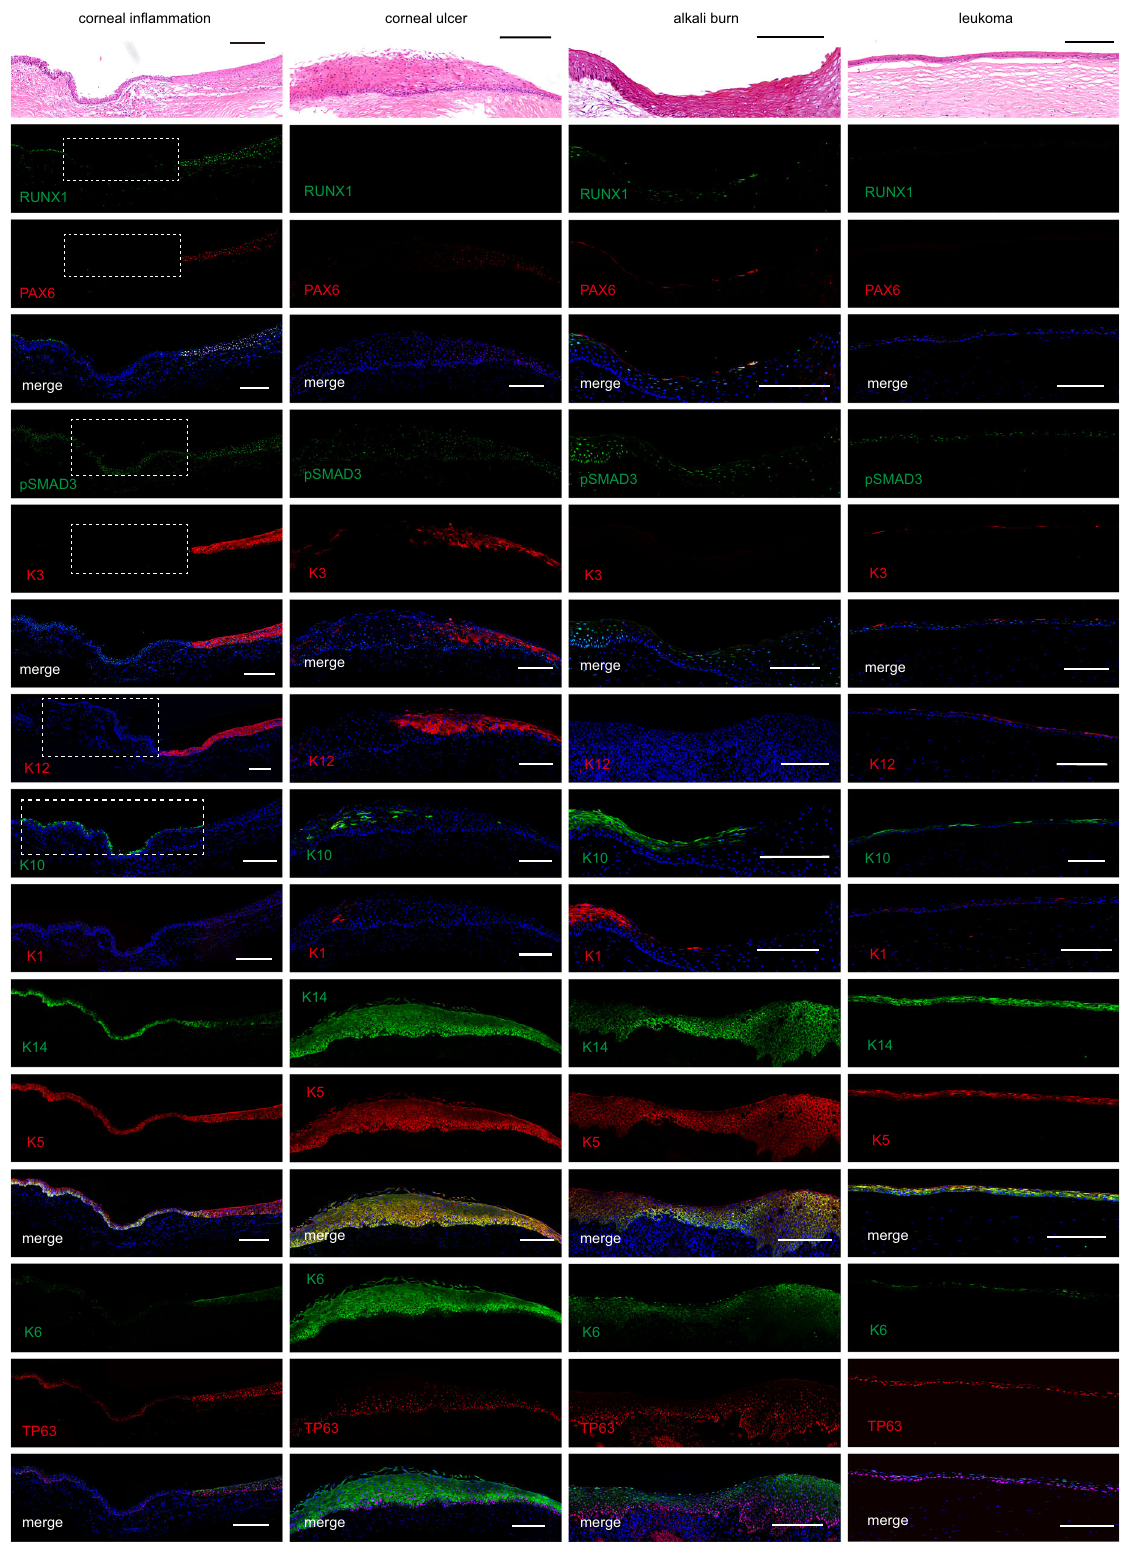
Fig. 6 Pathological changes of corneal epithelium. H&E staining and immuno fl uorescence analysis of the indicated genes in corneal in fl ammatory (47 years old, female), ulcer (62 years old, female), alkali burn (33 years old, male), and leukoma (51 years old, female) tissues. Scale bars, 200 μ